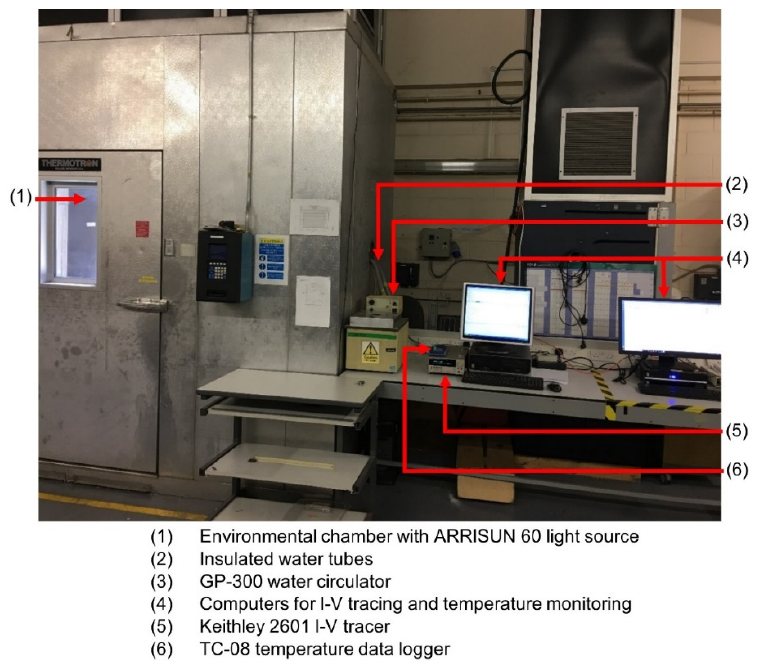
Figure 4. The facility for the characterisation of the solar cells and PV modules.